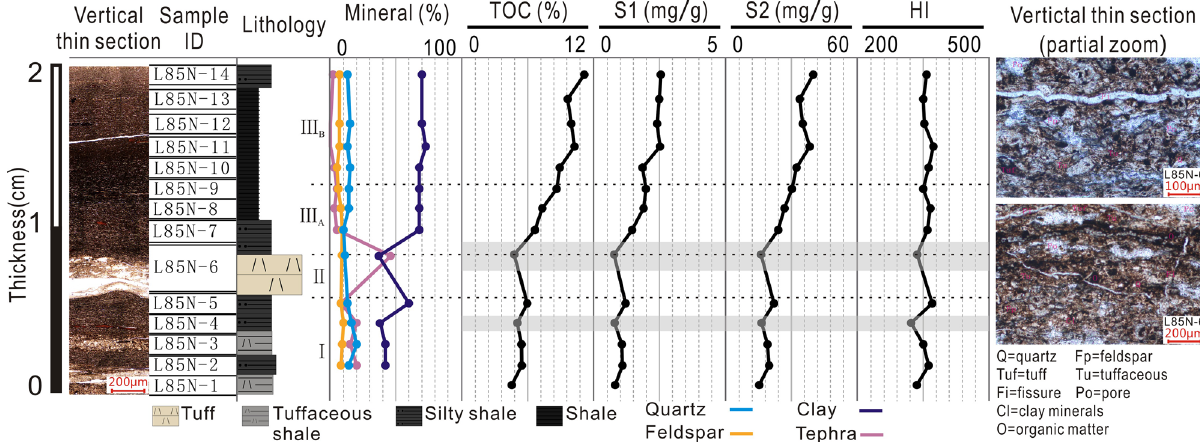
Figure 2. Lithology, mineral compositions, and geochemical indices of the studied samples. The vertical thin sections show the location of the tuff layer and 14 slices. The magnification of slice 6 confirms the structure and composition of tuff. S 1 is the free hydrocarbon. S 2 is the pyrolyzed hydrocarbon. HI is the hydrogen